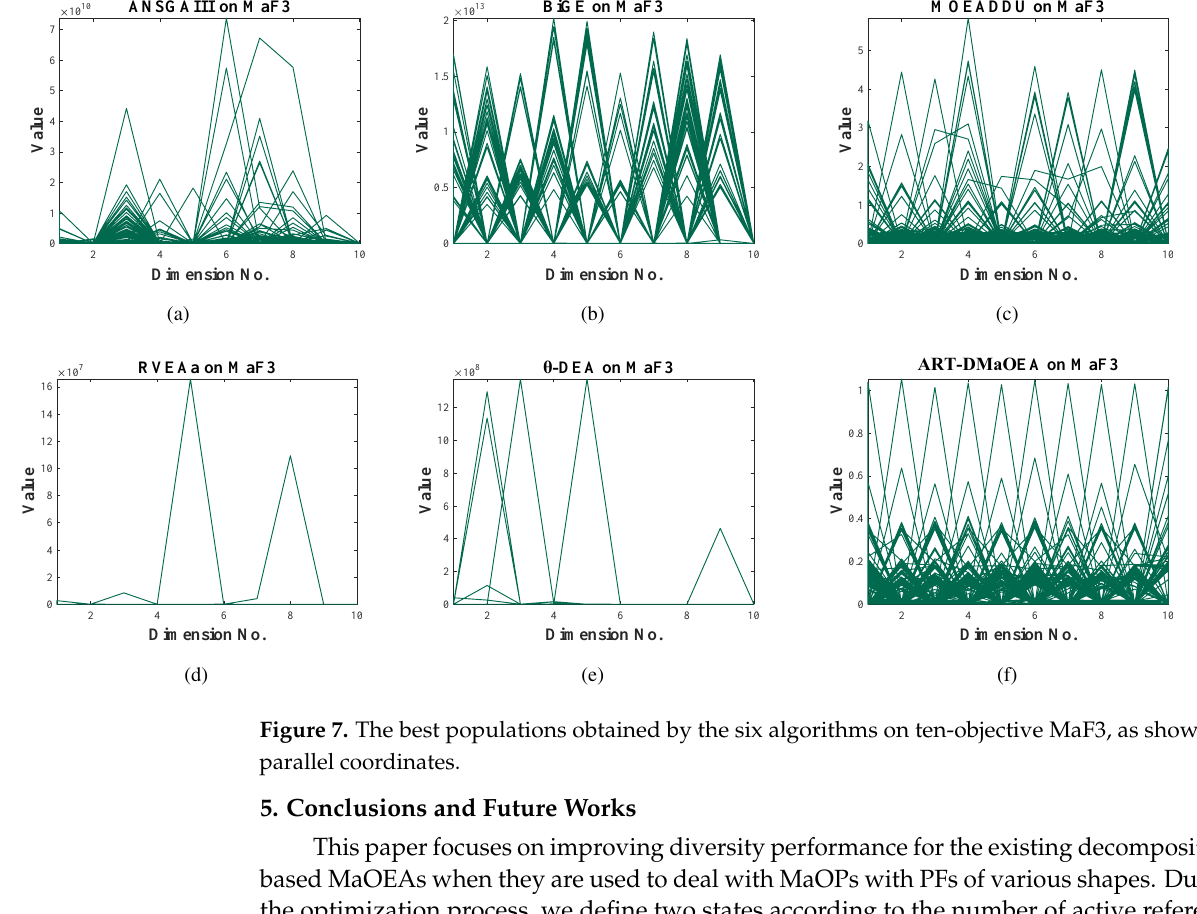
Fig. 6: The final populations obtained by the six algorithms on 10-objective MaF1, shown by parallel coordinates.